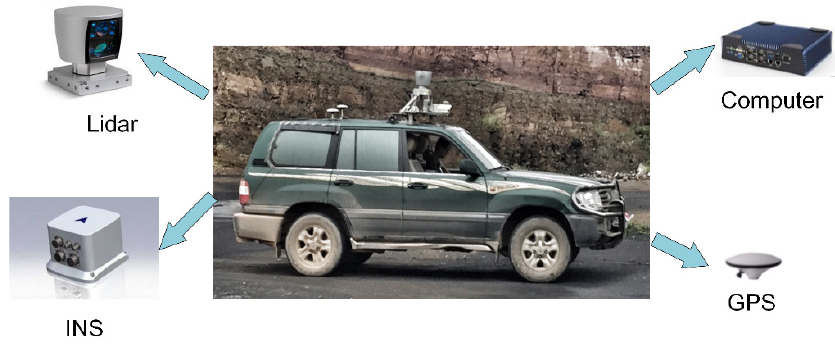
Figure 23. Components of the navigation control system.